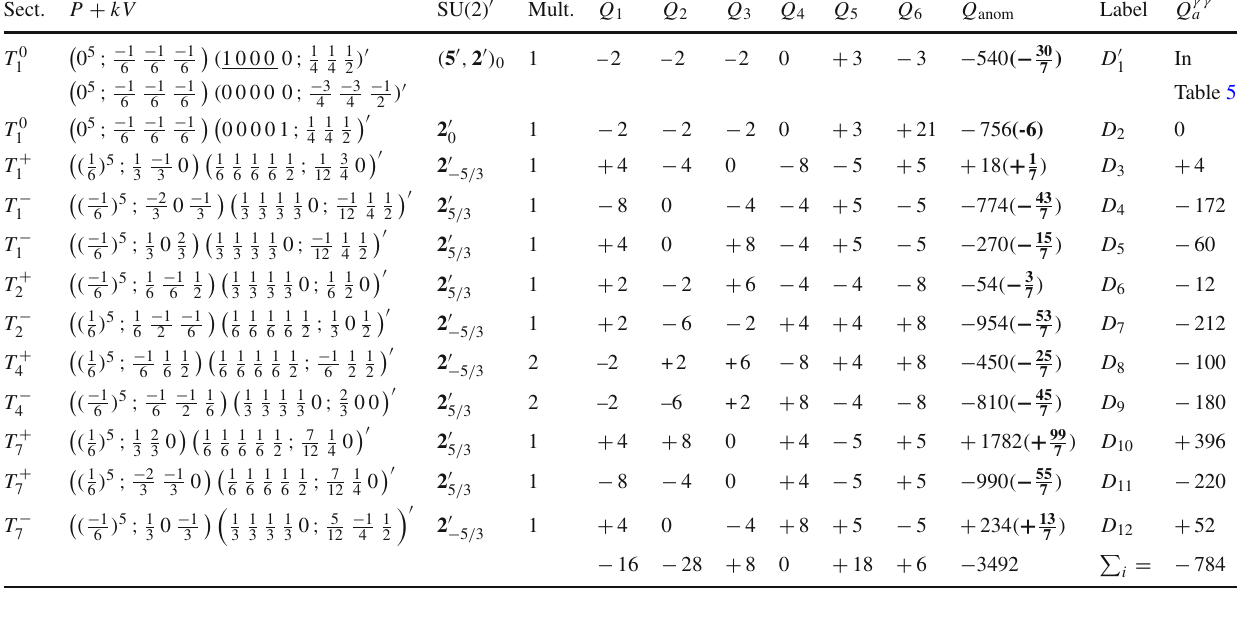
Table 6 The SU(2) (cid:2) representations. Notations are the same as in Table 1. We listed only the upper component of SU(2) (cid:2) from which the lower component can be obtained by applying T − of SU(2) (cid:2) Sect. P +